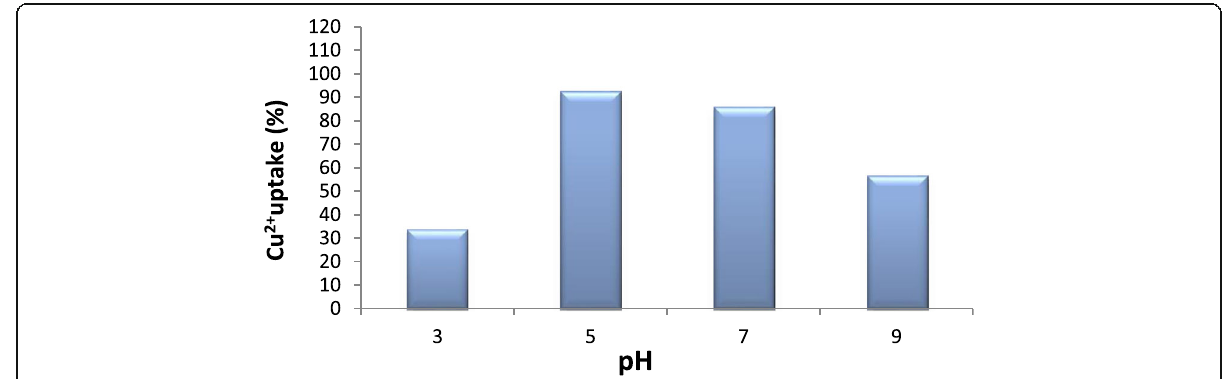
Fig. 3 Effect of initial pH on Cu 2+ uptake by Aspergillus tamarii NRC 3 biomass (Cu 2+ conc., 80 ppm)